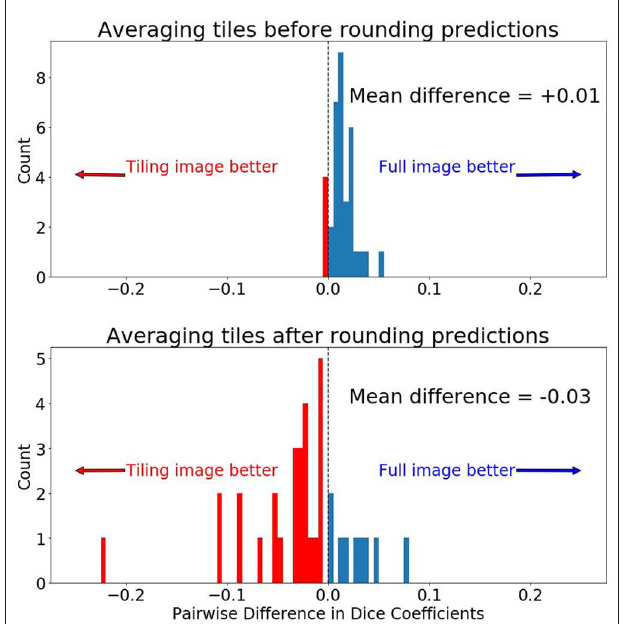
FIGURE 7 | The translationally-variant nature of the MaxPooling layer: note how the result of MaxPooling significantly differs with a translation of one pixel to the 10 × 2 window between the top and bottom inputs even though they contain the same values (middle rows). Successive MaxPooling layers (or any non-unary, strided convolution) compound the effect because they effectively increase the receptive field window size. Hence, a model with three 2 × 2 MaxPooling layers would show translational variance for offsets of up to 2 3 = 8